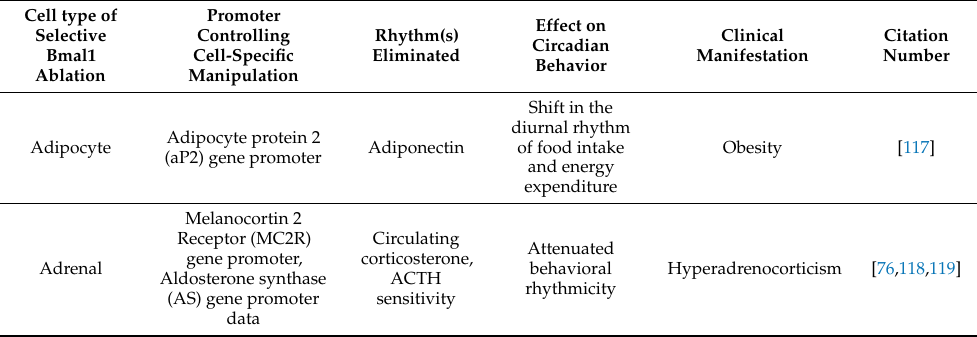
Table 1. A sampling of studies on the effects of tissue-specific Bmal1